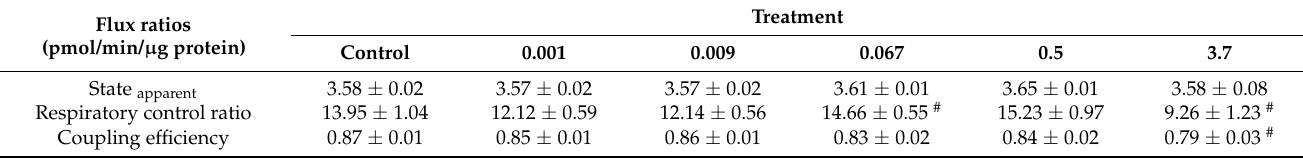
Figure 3. The effect of dimethyl sulfoxide (DMSO) the mitochondrial integrity of the ( A ) H9c2 cardiomyoblasts and ( B ) MCF-7 breast cancer cells. Cells were treated every second day for 6 days with varying DMSO concentrations (0.001, 0.009, 0.067, 0.5, and 3.7%). Data are presented as the mean ± SEM of 3 biological experiments with 5 technical repeats ( n = 3). Significance is indicated as ### p < 0.001 versus the control. Table 2. Respiratory flux ratios of DMSO treated MCF-7 breast cancer